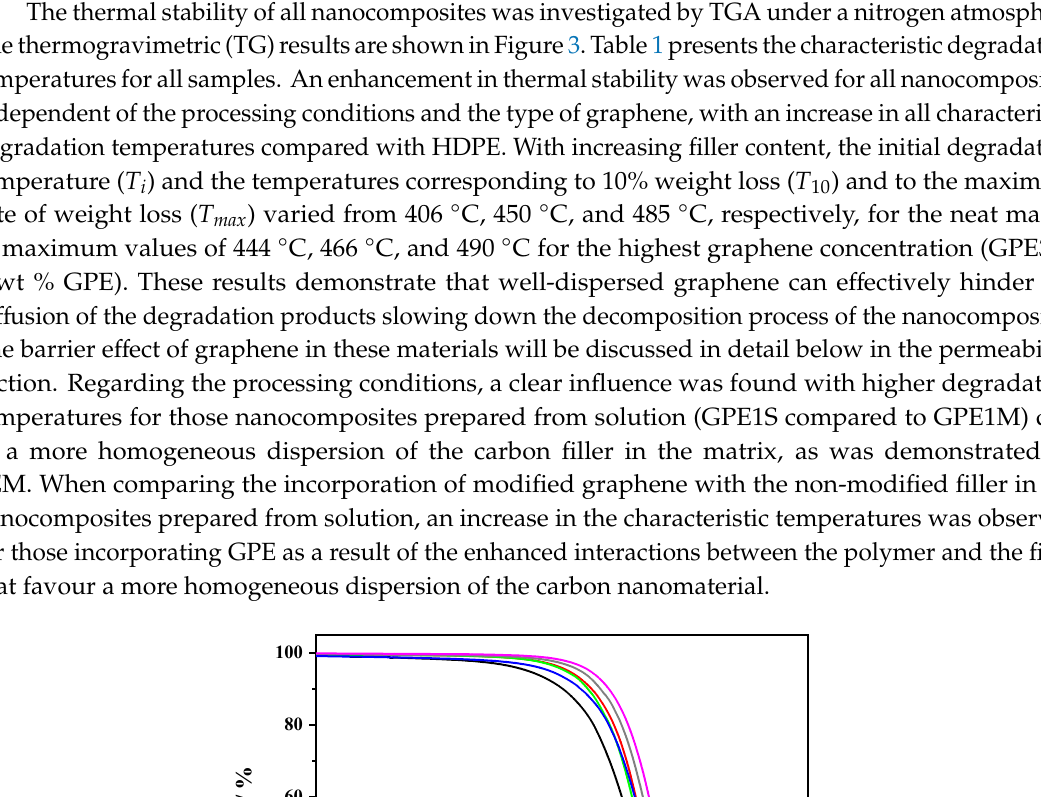
Figure 3. TG curves under a nitrogen atmosphere at a rate of 10 °C min −1 for the different samples.